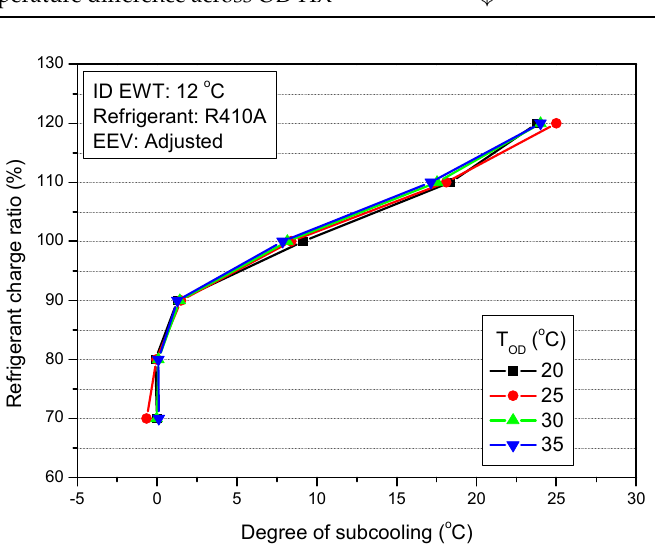
Figure 20. Degree of subcooling with variation of refrigerant charge ratio and T OD . Table 2 Parameter trend and characteristics of the water-to-water heat pump in cooling mode.